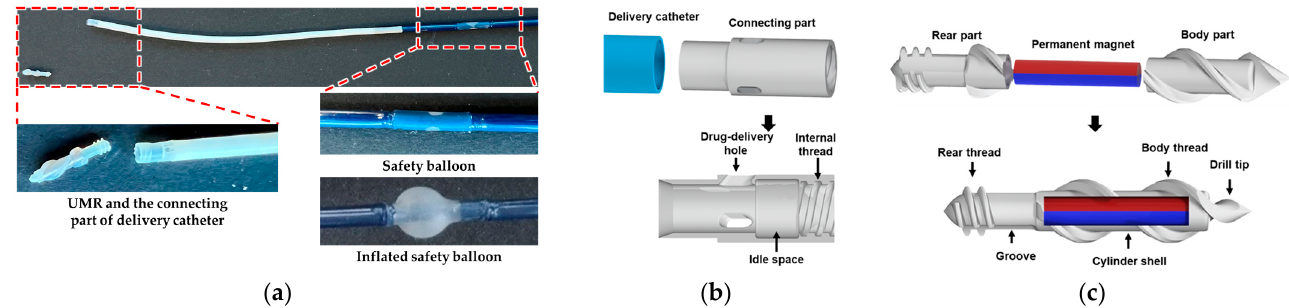
Figure 1. ( a ) An SRMR composed of a tethered delivery catheter with a safety balloon and an un- tethered UMR; ( b ) structure of the connecting part of the delivery catheter; ( c ) structure of the UMR.